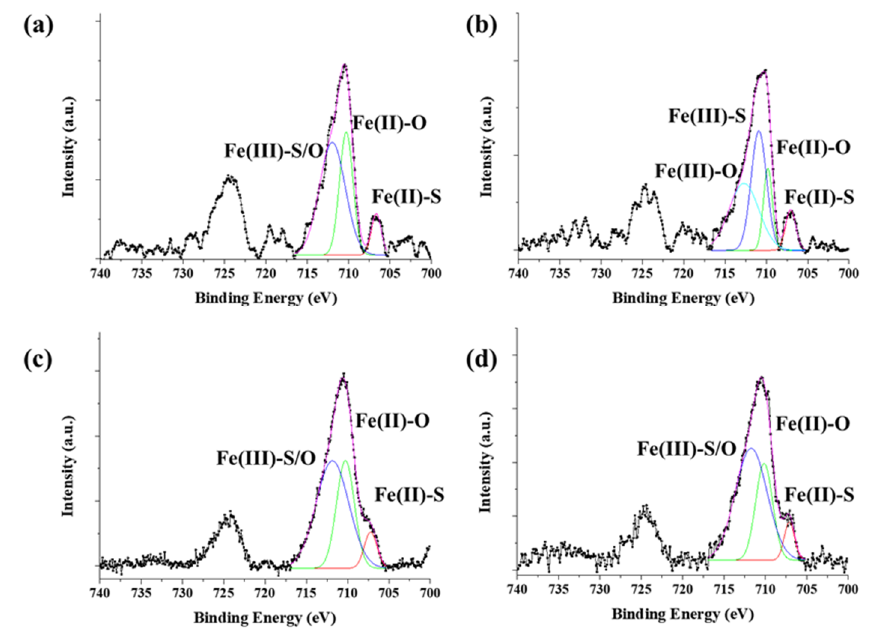
Figure 8. XPS spectra of Fe 2p of thermally decomposed catalyst precursors with sulfur: ( a ) ferrocene, ( b ) acetylferrocene, ( c ) ferrocenemethanol, and ( d ) 1,1′-diacetylferrocene.